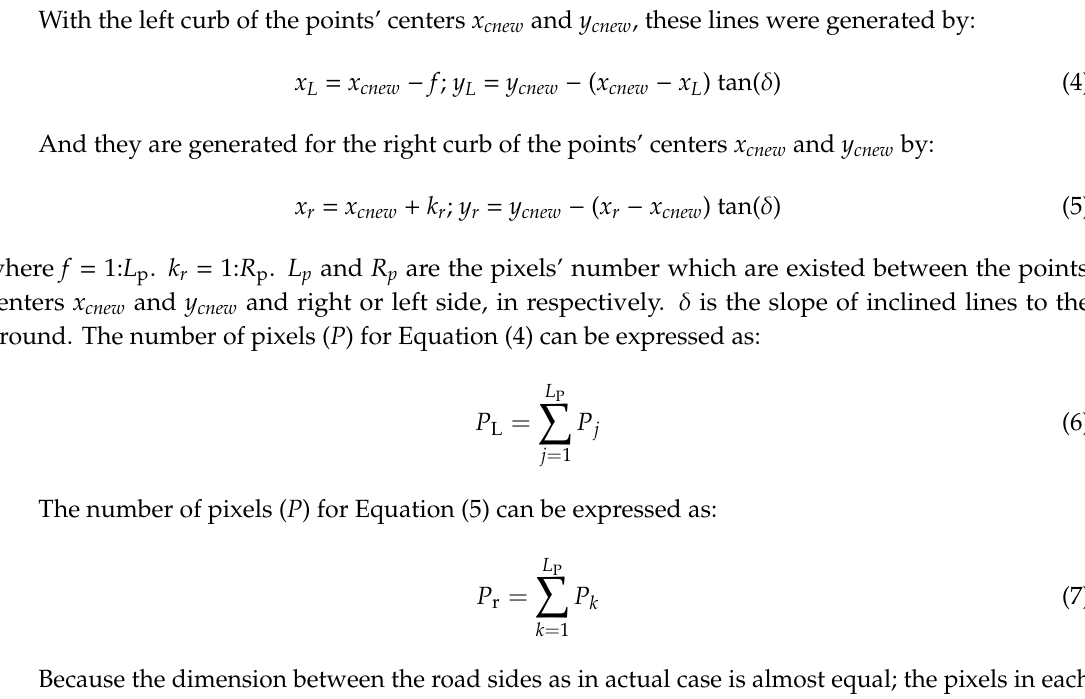
Figure 6. Image sequence with applying LS for roundabout determination at 100 m from the